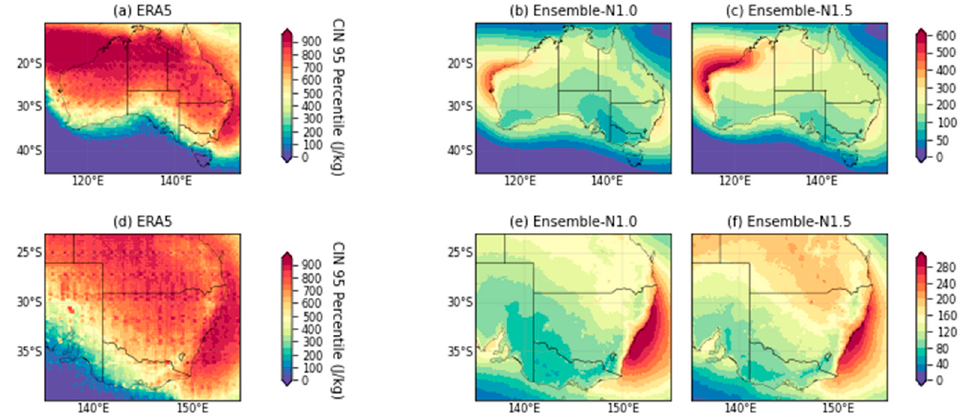
Figure 10. As in Figure 9 except for CIN.